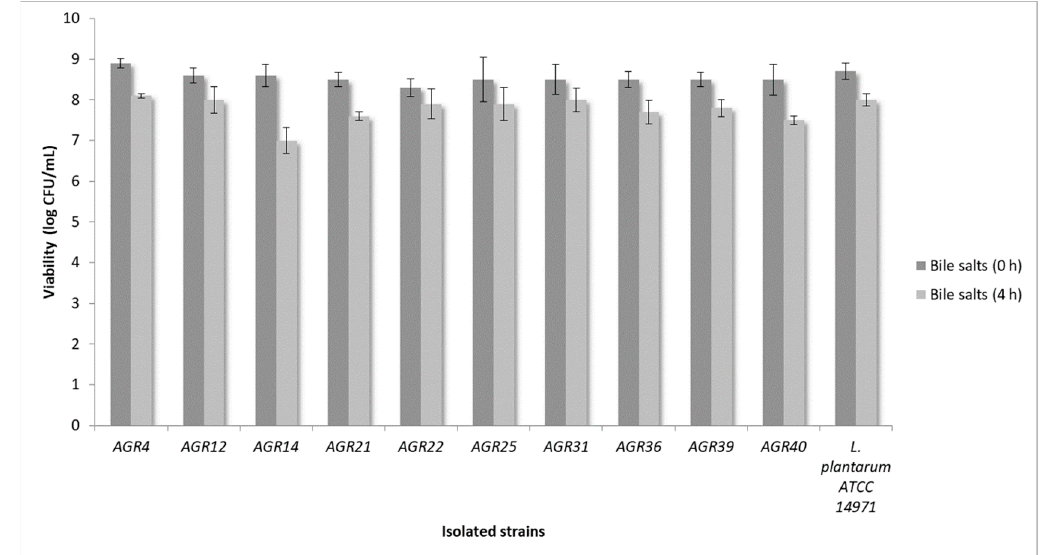
Figure 2. Assessment of strain viability after exposure to bile salts for 0 to 4 h.